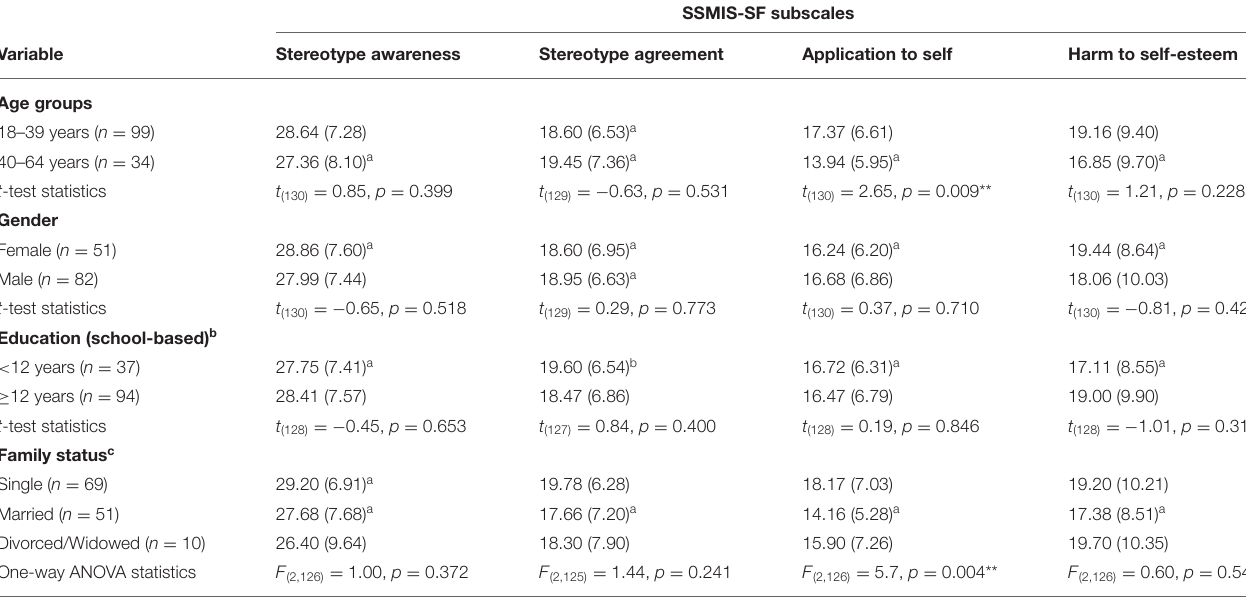
TABLE 4 | Means and standard deviations of mental health self-stigma scores according to sociodemographic